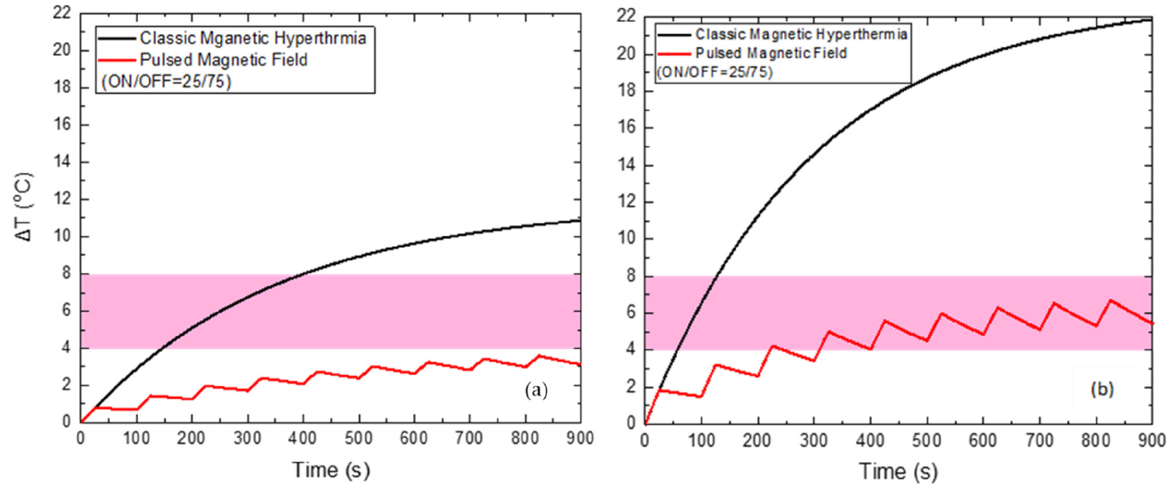
Figure 8. Temperature increase with time under 60 mT magnetic field after applying classic MPH (black) and PMF hyperthermia using ON/OFF = 25/75 s (red) for the HTP ( a ) and CTP ( b ) samples. Lastly, when applying a PMF of 70 mT (Figure 9) with the optimum ON/OFF = 25/100 s, the reduction of the maximum temperature of HTP by 8.8 °C and of CTP by 20 °C is also attained, compared to the classic MPH, while the total Hyperthermia Duration is zero for HTP. At the same time, Hyperthermia Duration reached 694 s for the CTP sample, when the corresponding time for classic MPH was only 43 s.